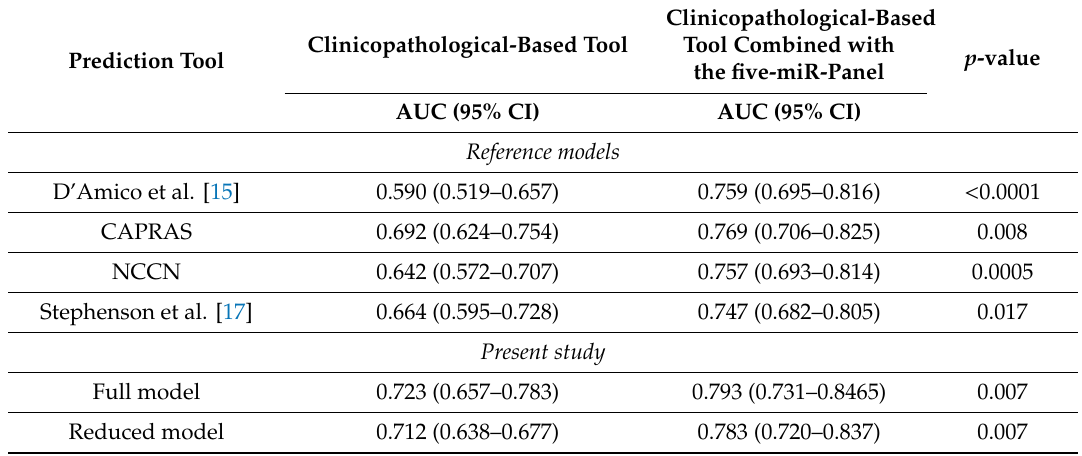
Table 7. Improved prediction of biochemical recurrence after radical prostatectomy, using clinicopathological-based tools in combination with the five-miR based